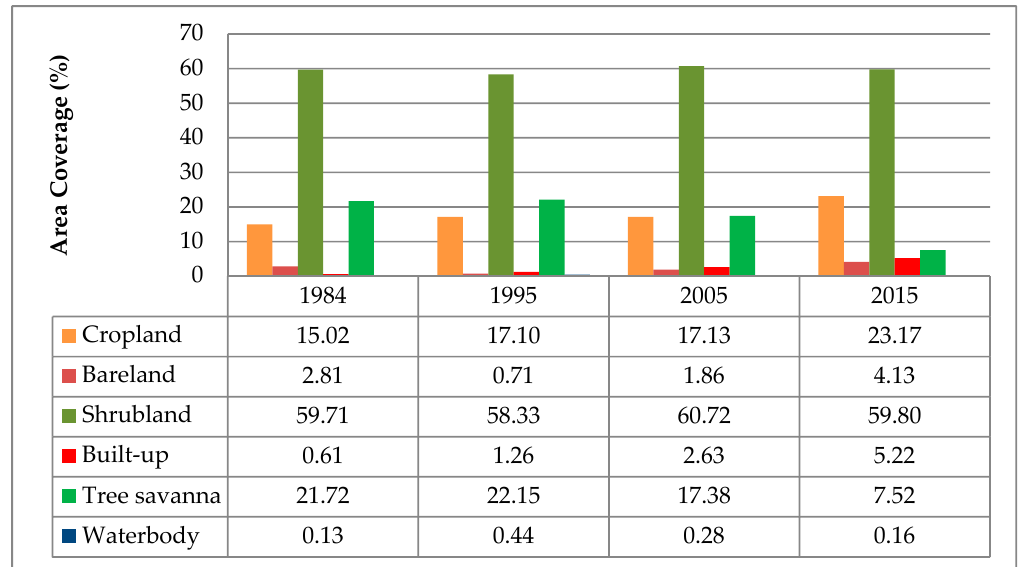
Figure 6. LULC area coverages in the Gaborone dam catchment from 1984 to 2015 (modified from [32]).